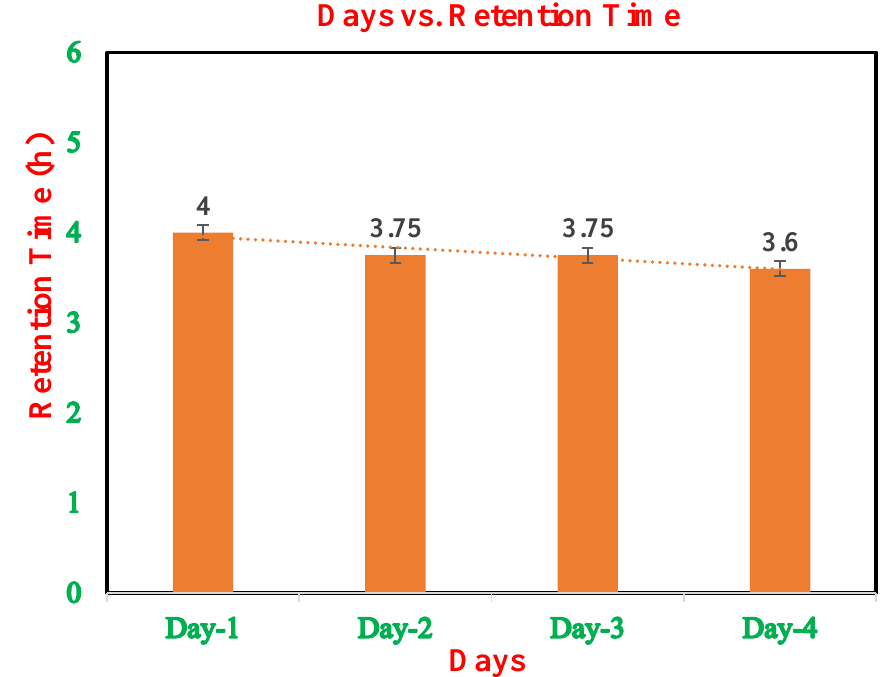
Figure 4. Retention time of filter on different days.